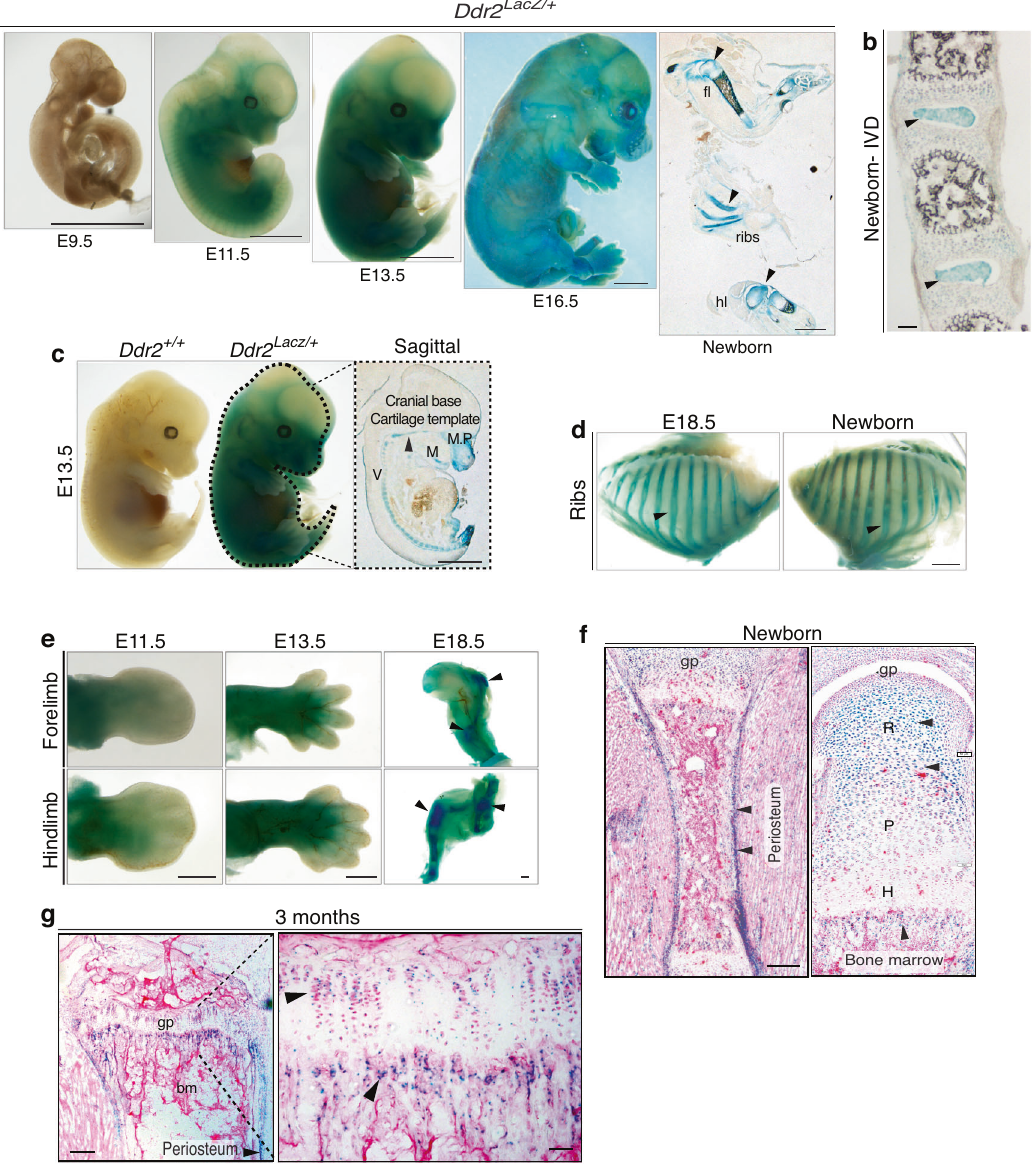
Fig. 1 Ddr2 is highly expressed in long bone growth plates, periosteum and bone marrow. a Left, whole-mount X-gal staining of Ddr2 Lacz/ + mouse embryos from E9.5-E16.5, showing of Ddr2 expression starting at E11.5; right, sagittal section (right of midline) of newborn showing forelimb ( fl ), ribs, and hindlimb (hl) staining. Scale bar: 2 mm. b X-gal staining of cryostat section of spine (intervertebral discs) from newborn mice. Scale bar: 100 μ m. c Side views of Ddr2 + / + (left) and Ddr2 Lacz/ + (right) embryos at E13.5. Midline sagittal section (right) of Ddr2 Lacz/ + embryo is indicated in dotted lines. Arrowhead points to cranial base cartilage template. M, Meckles cartilage; V, cartilaginous primordia of the vertebral bodies; MP, maxillary process. Scale bar: 2 mm. d Side views of rib cages from Ddr2 Lacz/ + mice at E18.5 and birth. Scale bar: 2 mm. e Whole-mount X-gal staining of Ddr2 Lacz/ + embryo forelimbs (upper panel) and hindlimbs (lower panel) at E11.5, E13.5, and E18.5. Scale bar: 500 μ m. f , g X-gal staining of cryostat sections of long bone from newborn and 3 month-old mice. R Resting zone; P Proliferative zone; H Hypertrophic zone; gp Growth plate. Arrowheads indicate areas of positive X-gal staining. Note: Newborn growth plate in ( f ) is a composite of three images. Scale bar: 200 μ m (left) and 50 μ m